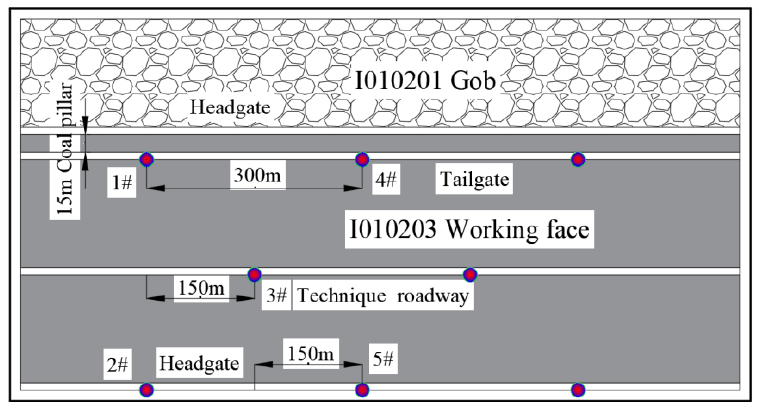
Figure 20. Layout map of the micro-seismic monitoring points.